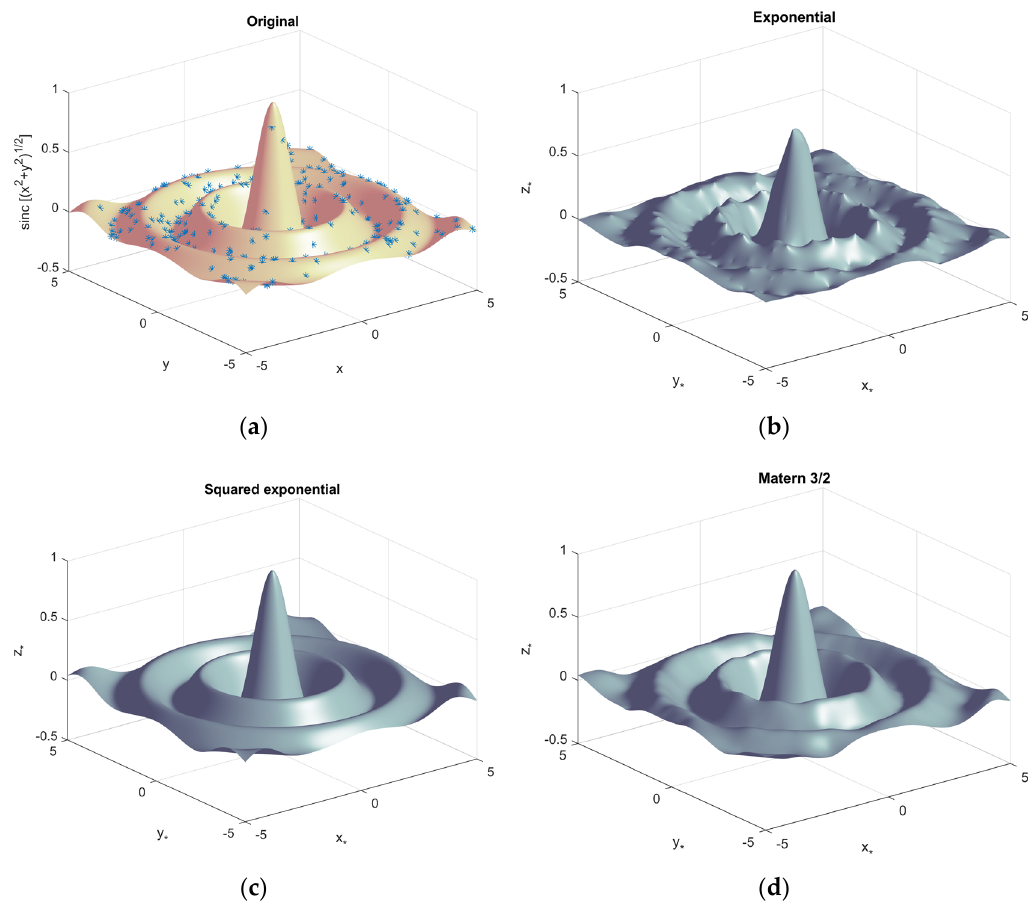
Figure 4. Gaussian process regression example by 3D sinc function. (Trained by 300 data points) ( a ) Original sinc function with one million data points. The * indicates training data points; ( b ) predictions by GPR with exponential kernel; ( c ) predictions by GPR with squared exponential kernel; ( d ) predictions by GPR with Matern 3/2 kernel.